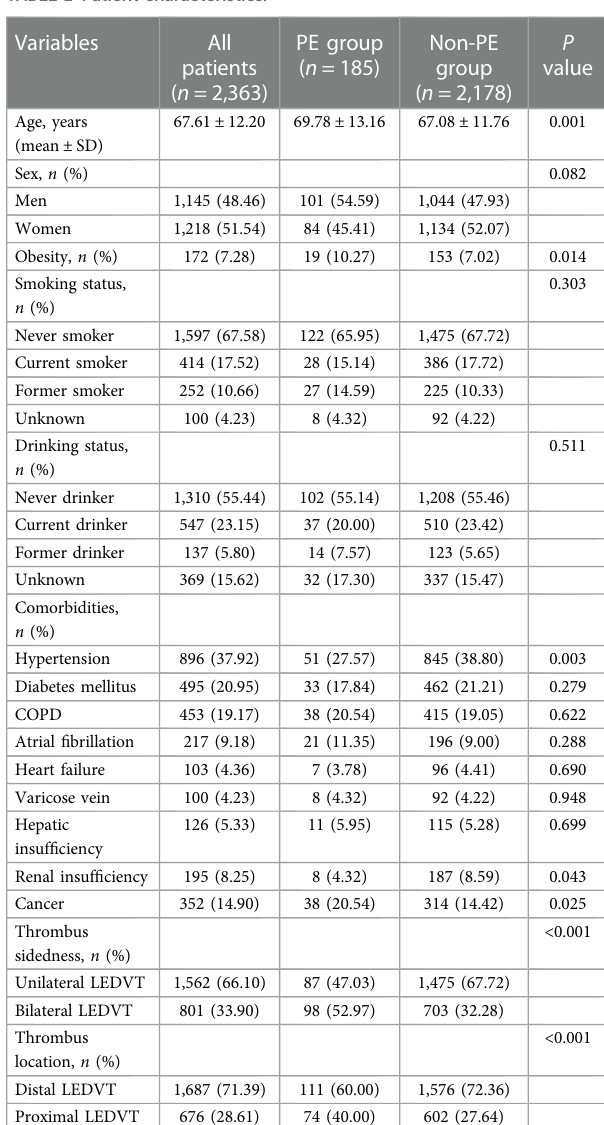
TABLE 1 Patient characteristics.